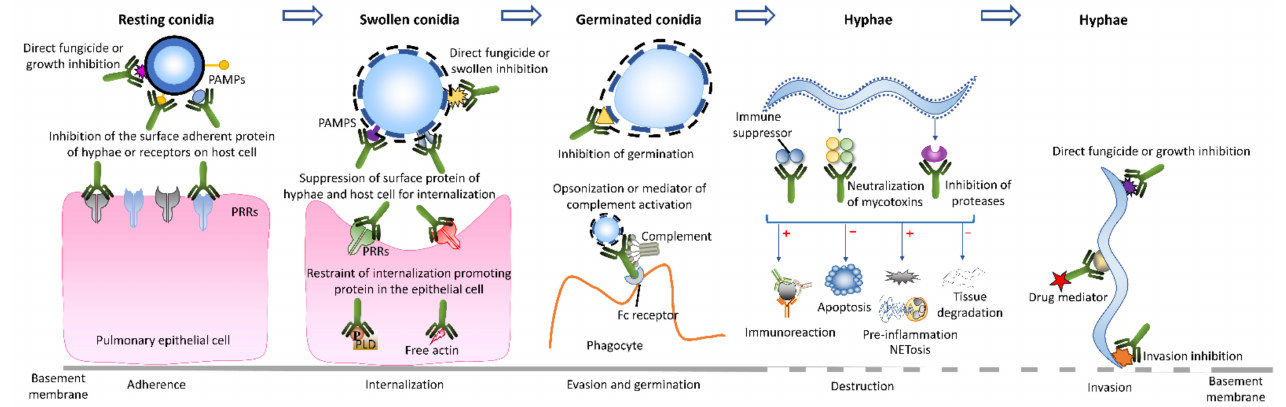
Figure 2. Monoclonal antibody-based modes to suppress or eliminate Aspergillus